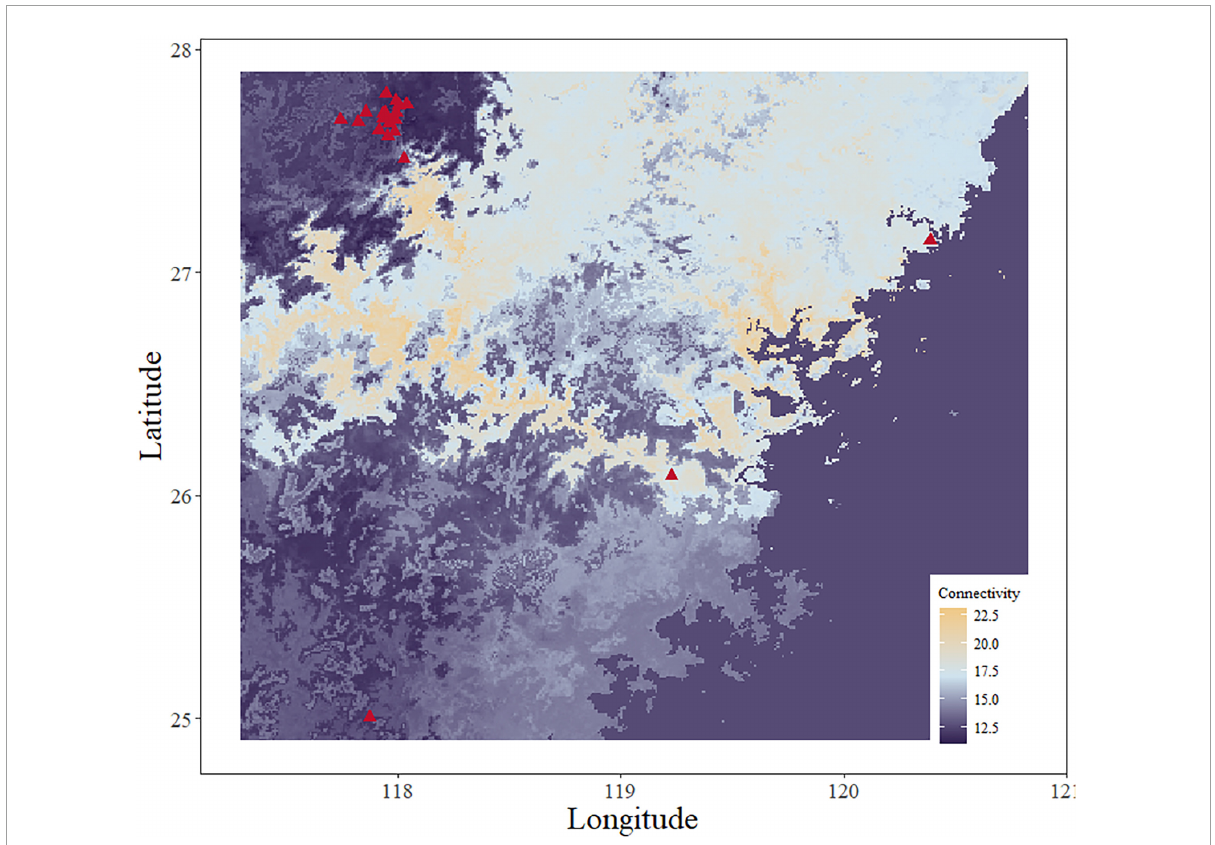
FIGURE7 Genetic connectivity map using the F ST full set. The red triangle shows the collection sites for S. empoasca (genetic